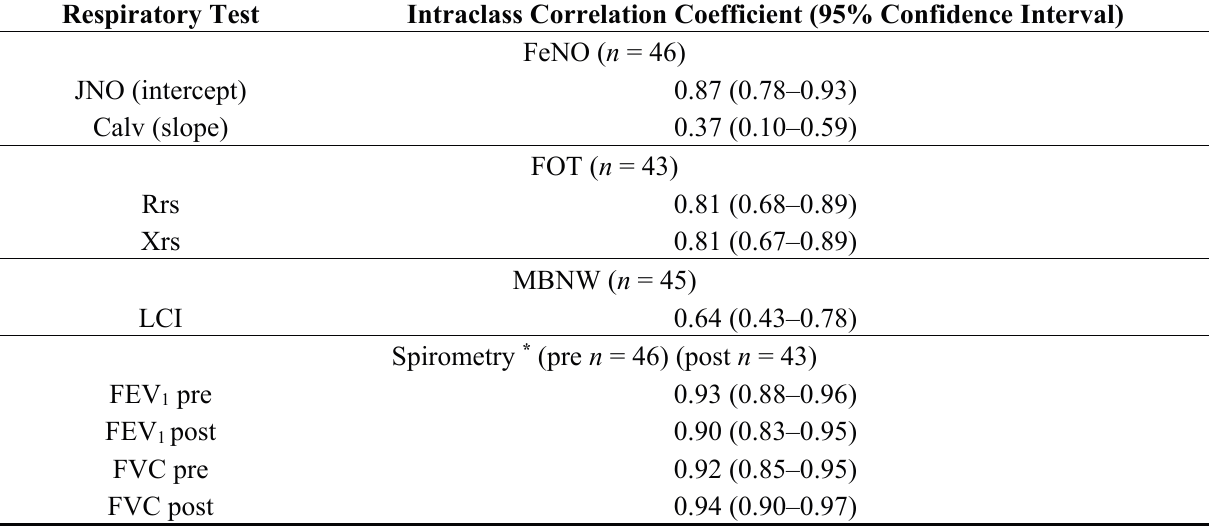
Table 2. Reliability of respiratory tests conducted in the UPTECH pilot